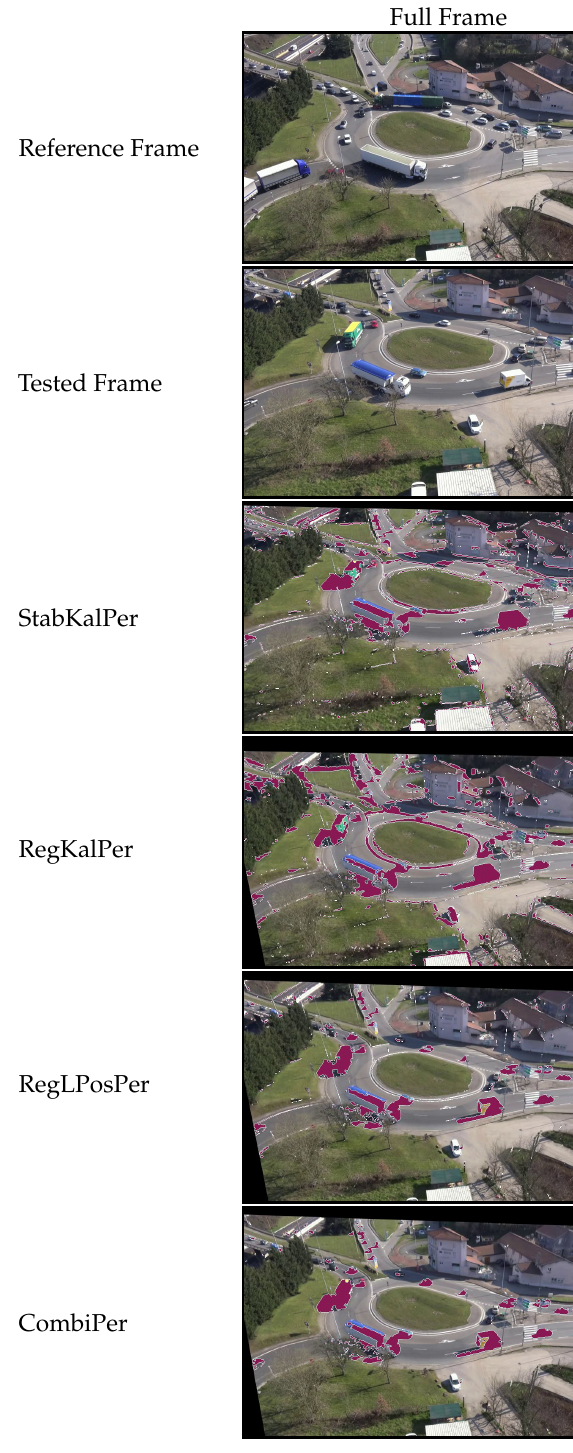
Figure 11. Results from the tested perspective methods on the sequence MFull. Test-Frame is picked approximately 38 minutes after the start of the video. To emphasize differences, we have displayed the output of the Background Subtraction algorithm ViBe[28] on tested configurations (segmented parts in purple, contours in white). Full frame (center column) is cropped at a fixed location (right column) to better show details.